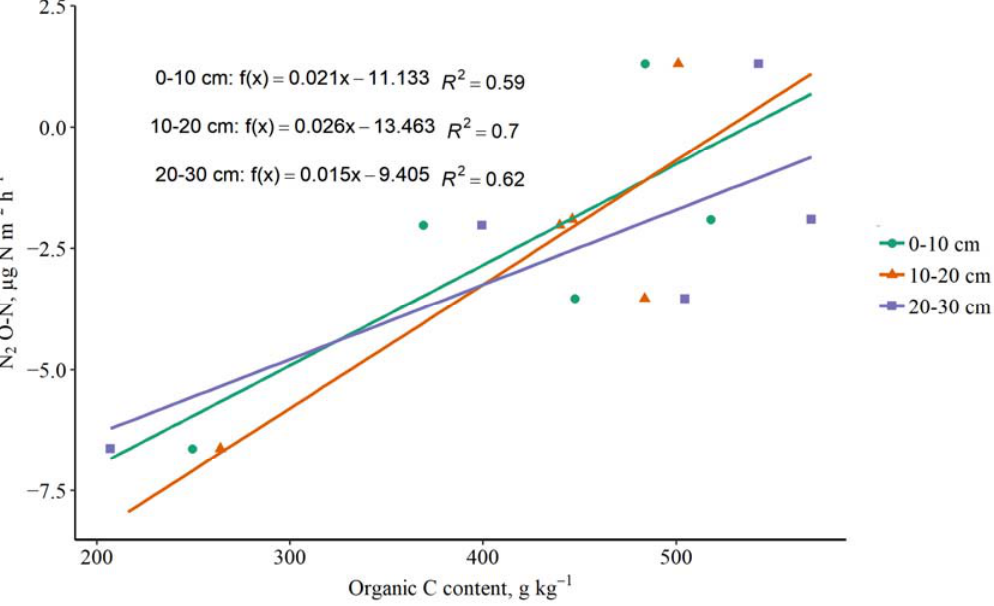
Figure 12. N 2 O fluxes depending on organic C content in soil in silver birch and black alder stands without outliers.